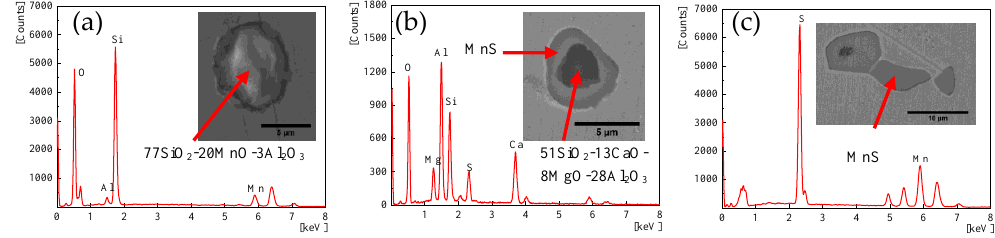
Figure 10. Typical inclusions at the normal experimental heat.